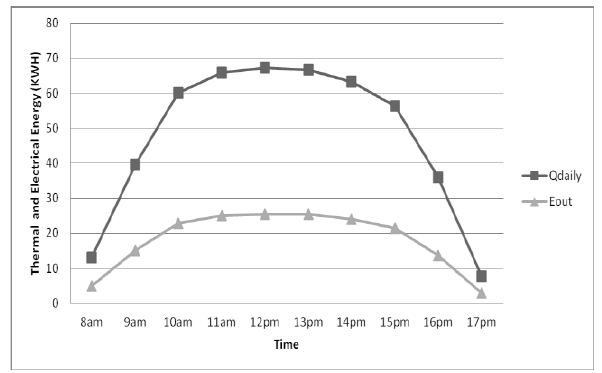
Figure 7: Variation of Electrical and Energy efficiency with Time